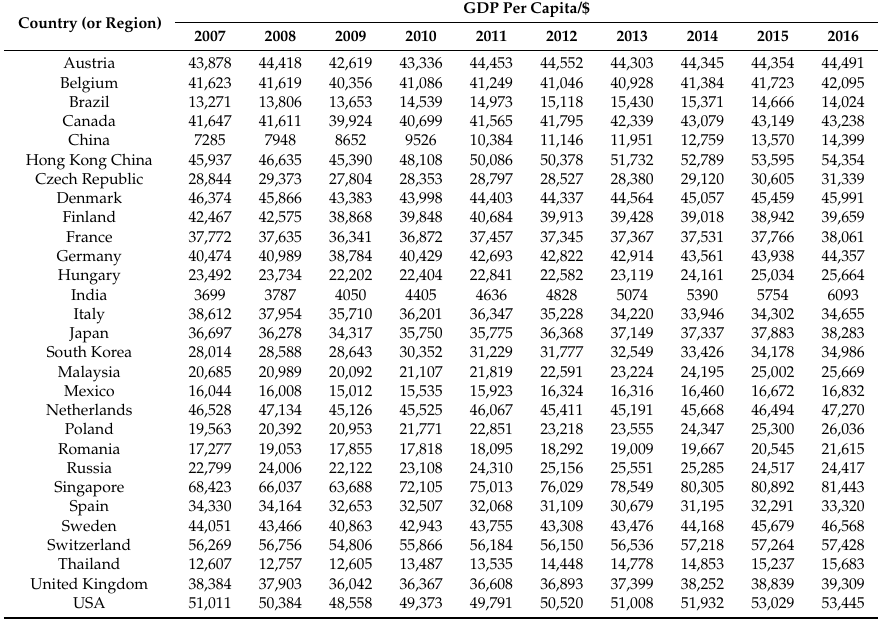
Table A2. The gross domestic product (GDP) 1 per capita of major exporters, based on purchasing power parity (PPP) 2 from 2007 to 2016. Country (or